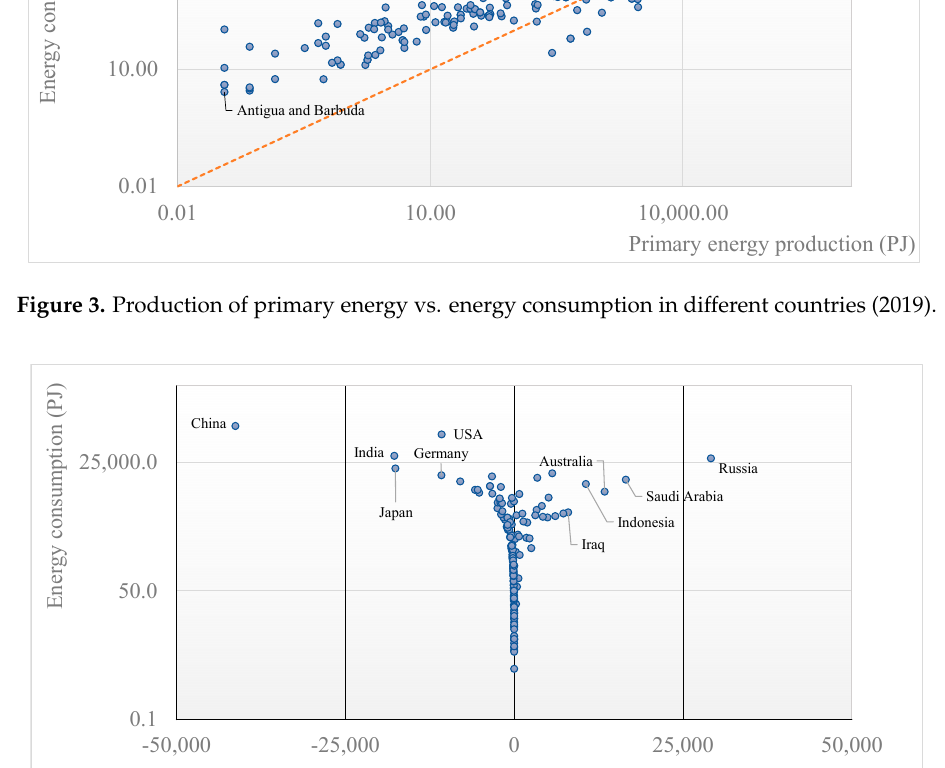
Figure 4. Balance of energy vs. energy consumption in di ff erent countries (2019). Evaluating the balance per capita, a minimum level is observed in food (Figure 5a), which indicates that the availability of food through autonomous production tends to be a priority of each country. On the contrary, the balance of energy per capita (Figure 5b) is more spread out, as energy needs depend on the industrial level, the climatic zone, or the habits of people. An interesting example is Mali, which has the maximum surplus per capita: the energy consumption per capita is less than 150 kWh [125] per year, while, in developed countries such as the USA, it is more than 10,000 kWh per year [126]. Highlighting the correlation between energy and food, we note that the production of food in energy units is about half of the primary energy production, while the FAO estimates that 30% of energy is consumed for agriculture [127]. It is also important to note that the literature has assumed a causal relationship between energy consumption with GDP and life expectancy [106,111,128]. ( a ) ( b ) Figure 5. ( a ) Food balance per capita vs. population; ( b ) Energy balance per capita vs. population (2019). Water participates in the WEF nexus with many uses (drinking, hygiene, irrigation, hydropower). Water availability varies globally, and, therefore, in order to standardize its value, we considered the total water withdrawals, which are available from the database